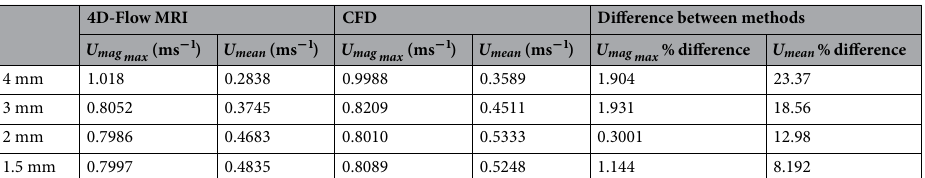
1 Table 4. Velocity magnitude ( ms − ) data at the inlet plane during systole calculated using 4D-Flow MRI data and CFD data, including a comparison between the two methods for each spatial